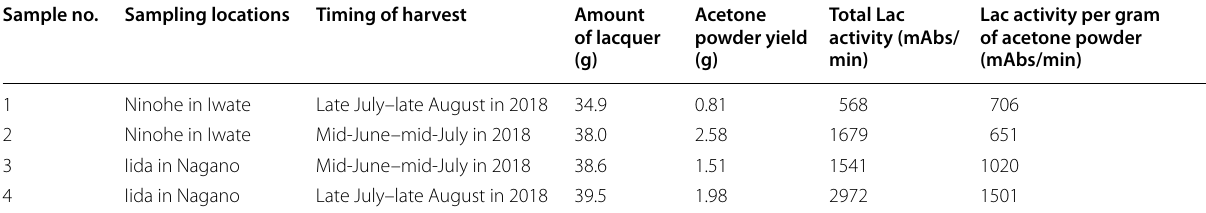
Table 1 Preparation of crude laccase from lacquer tree Sample no.